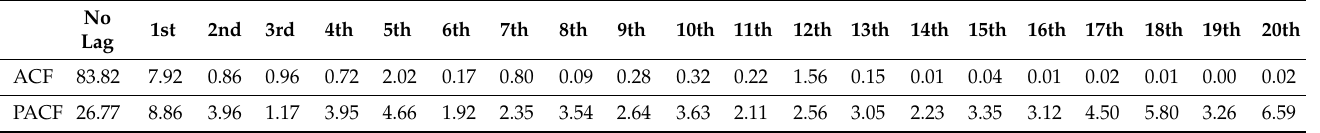
Table 1. Percent of nodes with statistically significant lags of annual ACF and